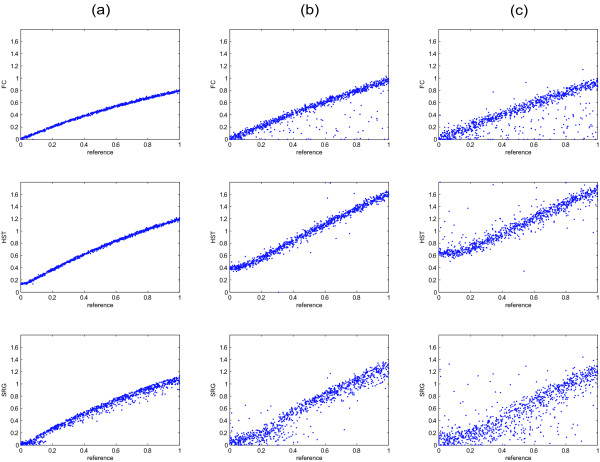
Results of segmentation example. The spot intensities estimated from the simulated images with the fixed circle (first row), the histogram segmentation (second row), and the seeded region growing (third row) segmentation algorithms are plotted against the input data (reference). The plots are from the first channel of the test images: (a) intensities for the high quality image given by the three segmentation algorithms, (b) intensity plots for image with noise and errors, (c) plots for image with disturbing noise and artefacts.